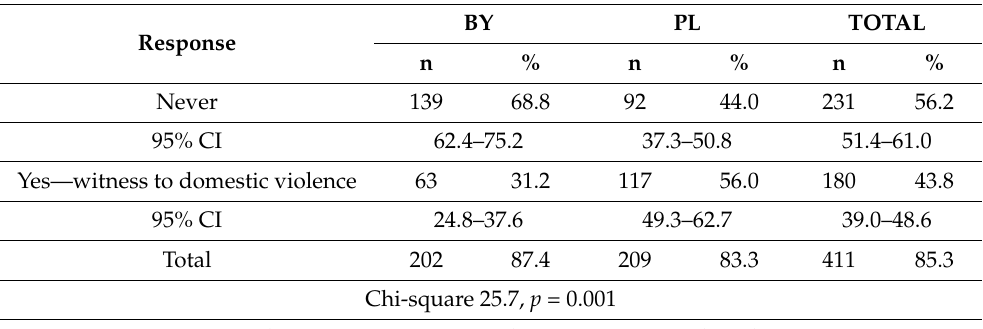
Table 1. Involvement in domestic violence (non-responses were not counted). Have You Been a Witness to Domestic Violence (in Your Own Family or